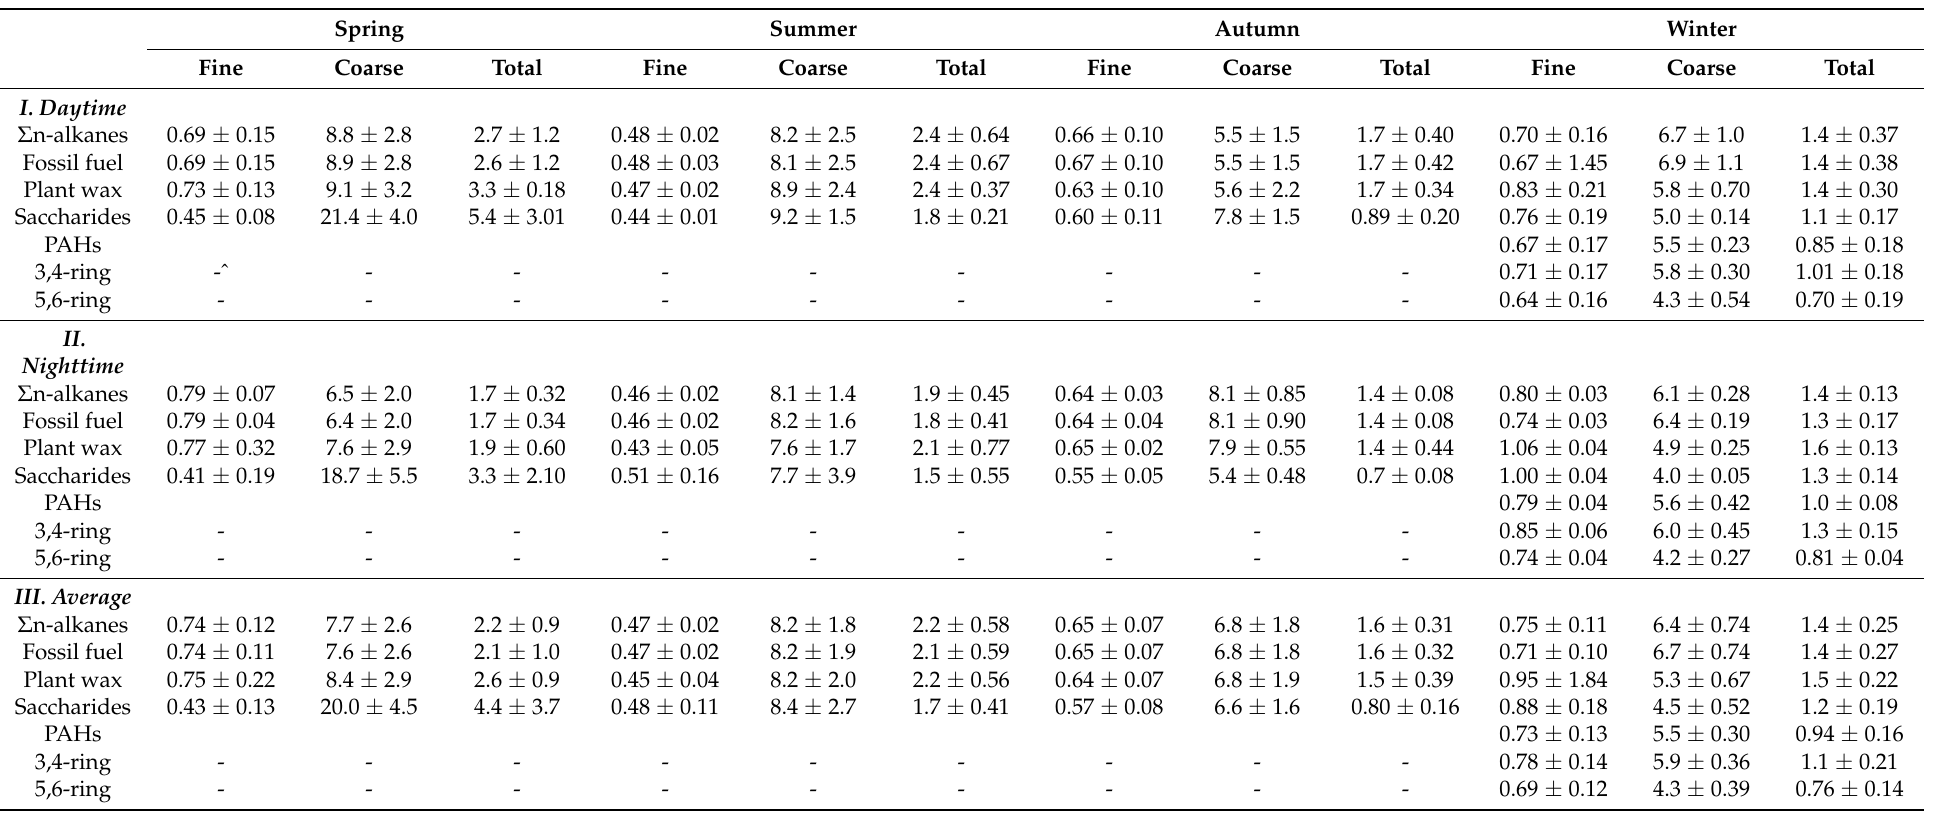
Table 2. Geometric mean diameter (GMD, µ m) of the fine (<2.1 µ m) and coarse ( ≥ 2.1 µ m) particles and the whole range of particle sizes (total) in the four seasons (the confidence interval represents the standard